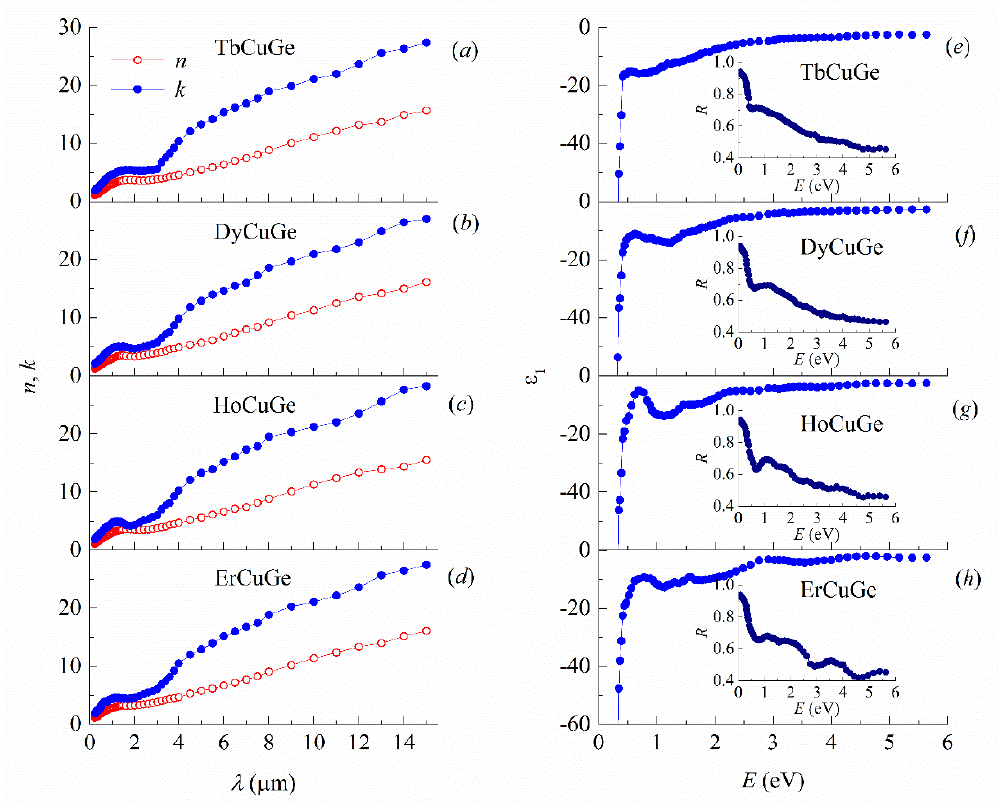
Figure 4. Optical constants n and k depending on wavelength λ for ( a ) TbCuGe, ( b ) DyCuGe, ( c ) HoCuGe and ( d ) ErCuGe. Dependencies of real part of dielectric permeability ε 1 and reflectivity R depending on photon energy E for ( e ) TbCuGe, ( f ) DyCuGe, ( g ) HoCuGe and ( h ) ErCuGe.